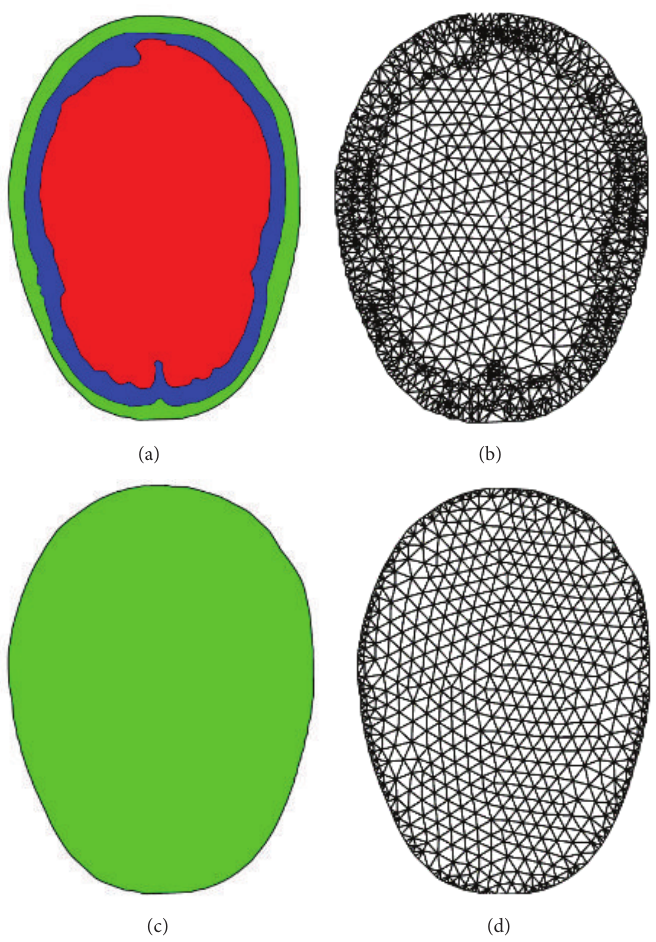
Figure 1: Existing FEHM: (a) geometric model, (b) FE mesh; the proposed FEHM: (c) geometric model, (d) FE mesh.